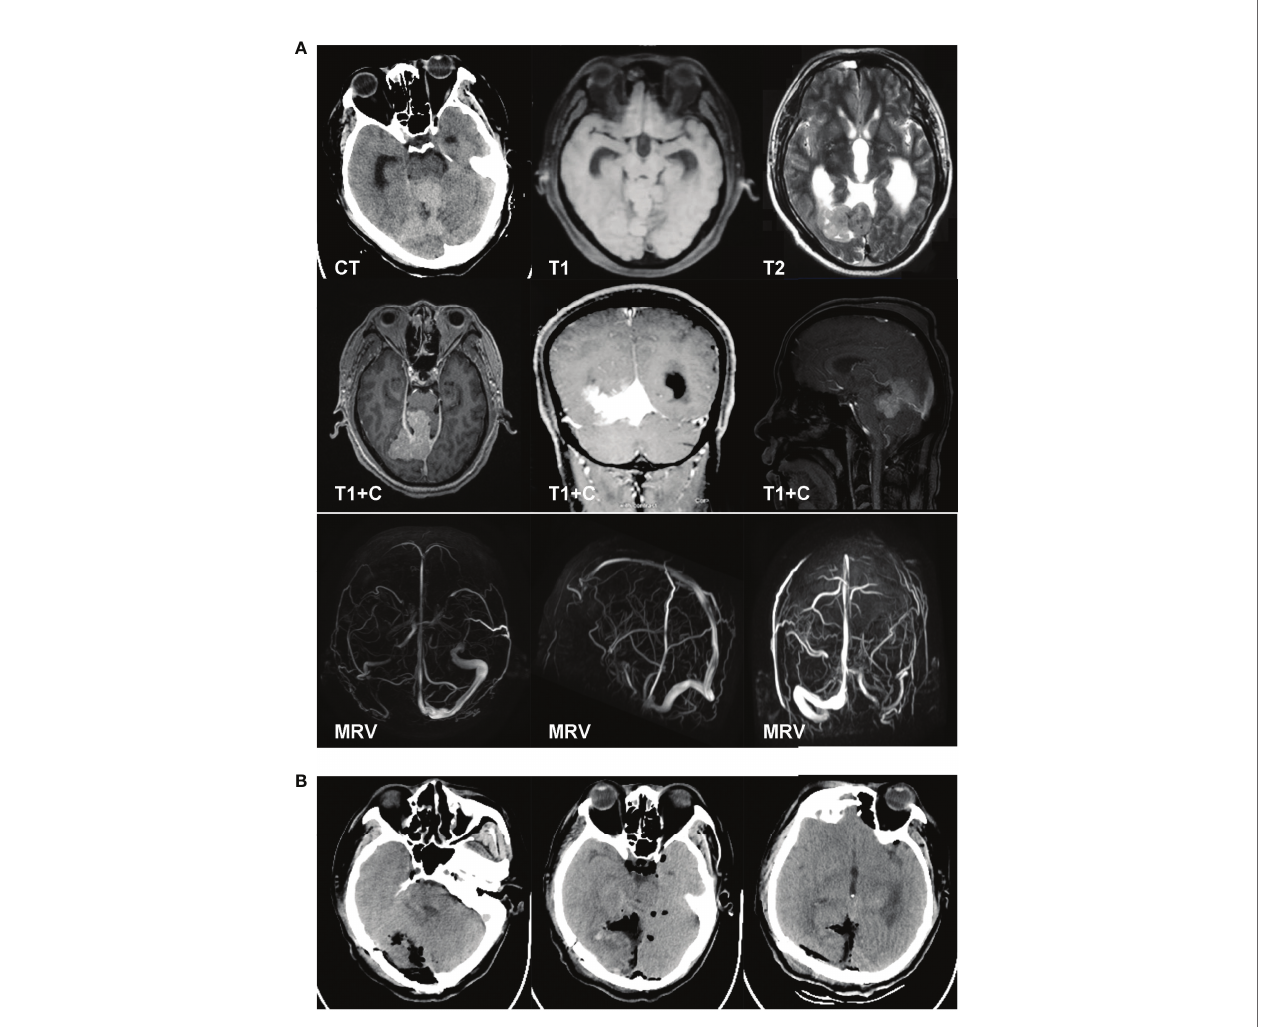
FIGURE 2 | A 52-year-old man complained of blurred vision and unsteady gait for 2 months. The physical examination results showed left hemianopsia, and both VOS and VOD were 0.1. The MRI results revealed a falcotentorial meningioma, which had an isointense signal on T1-/T2-weighted imaging and homogeneous enhancement on contrast-enhanced MRI. The magnetic resonance venography results showed that the straight sinus was occluded (A) . We implanted an Ommaya reservoir at 1 week before tumor resection and maintained the drainage at 200 ml per day. The patient then underwent tumor resection using the occipital interhemispheric approach. During the operation, the majority of the tumor base was located at the falx end and the tentorium. The tumor was removed in a piecemeal fashion. Finally, the tumor and the base were totally removed (Simpson grade I resection). The postoperative CT showed no hemorrhage or infarction (B) . The pathology examination results revealed that the tumor was a hemangiopericytoma, WHO grade